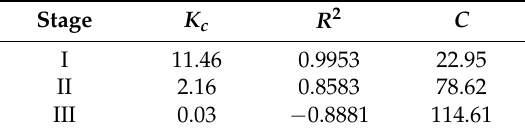
Table 2. The parameters of the three stages of the I-R